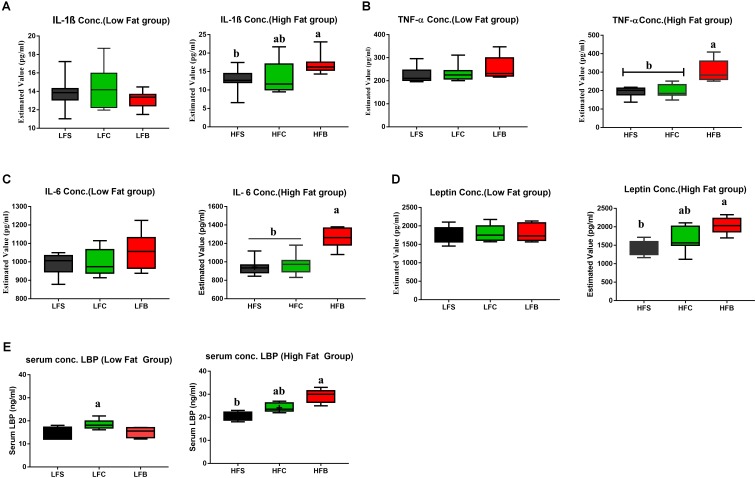
(A–D) Box-plots of serum inflammatory factors; (E) LBP. The data represent group means ± SEM and different letters denote statistical significance (P < 0.05).